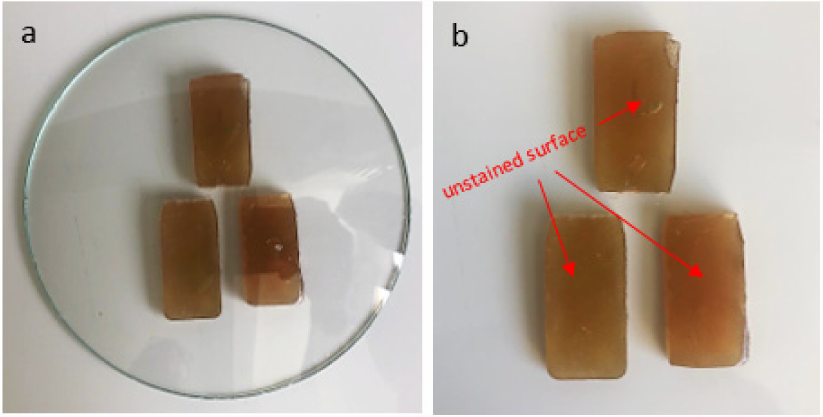
Figure 9. ( a ) A PET 5% samples exposed to detergent neutral detergent for 24 h; ( b ) test result.